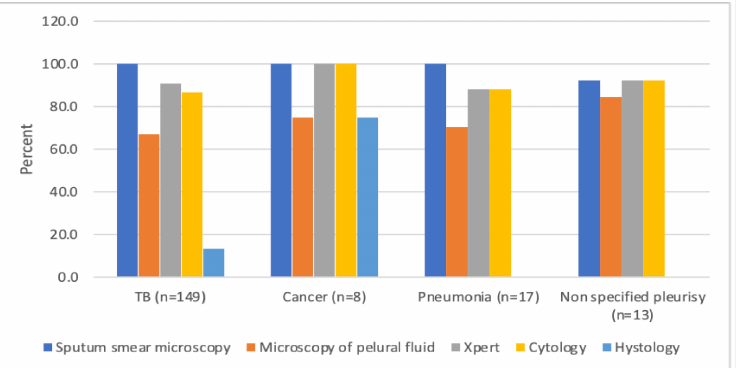
Figure 1. The proportions of different diagnostic procedures undertaken in patients with pleural effusion in relation to the final diagnosis in the Republican Specialized Scientific Practical Medical Center of Phthisiology and Pulmonology (RSSPMCPP), Tashkent, Uzbekistan, 2017–2018. Among 187 patients with bacteriological examinations, cytology, and histology tests, 149 (79.7%) were diagnosed with tuberculosis pleural effusion. Eight (4.3%) patients had cancer, 17 (9.1%) patients had pneumonia, and 13 (6.9%) cases remained unspecified. Thus, 38 patients were excluded from the final analysis which focused on those with diagnosed